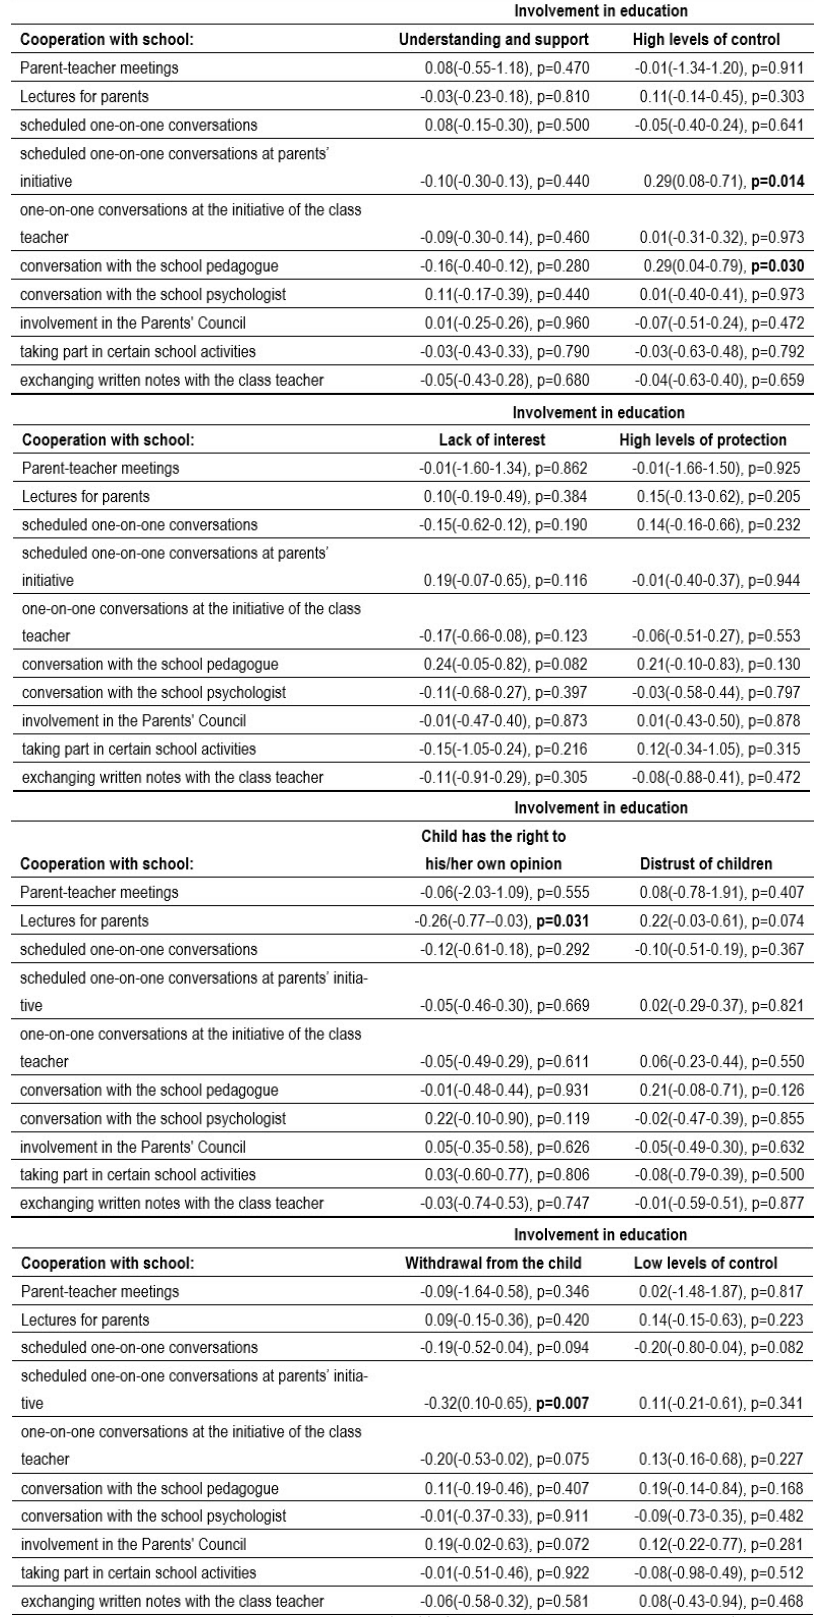
Prediction of the type of mothers’ involvement in child’s education based on their cooperation with